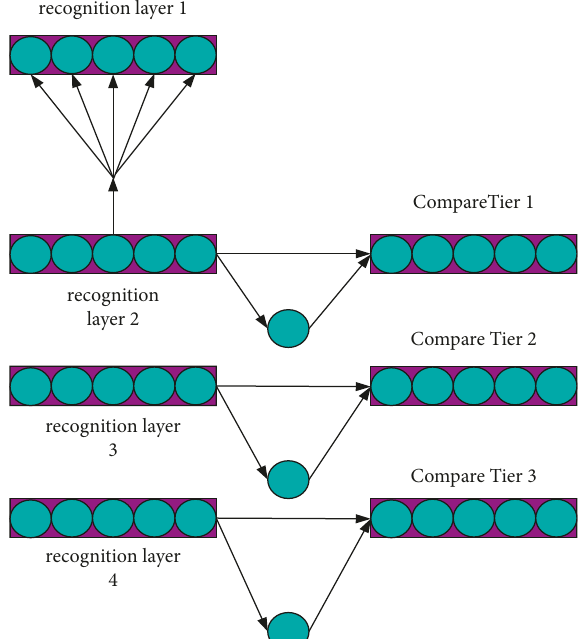
Figure 4: Neural network fine-tuning